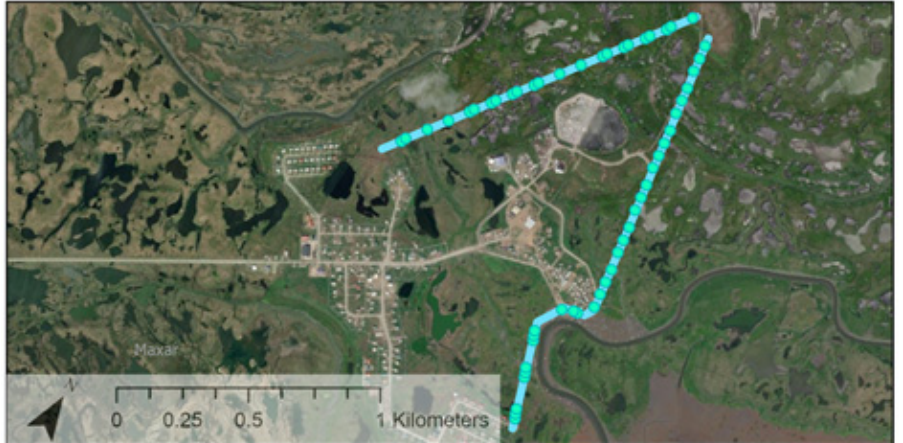
Figure 8. Planned large dike mitigation.